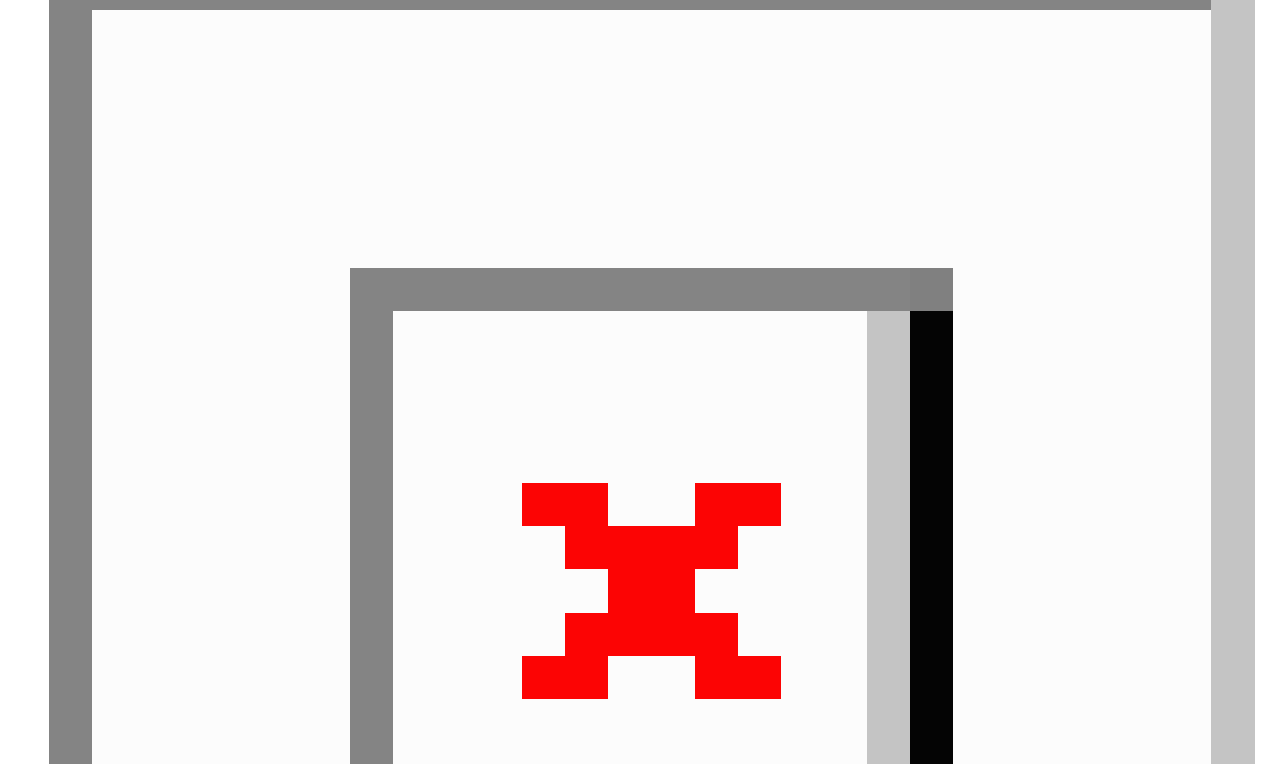
Figure 4. Top row: Simulations based on individual agents with a finite range of spreading the disease, D 0 . Left: various values of D 0 ; the case D 0 =100 already approaches the limit of free motion throughout the system, D 0 =L/2, see also Figure 3. Right: several instances of D 0 =25, labeled (a), (b), (c), exhibiting multiple bumps and long tails. Bottom row: the actual infected populations at the same time moment t =30 days, for D 0 =50 (left) and D 0 =100